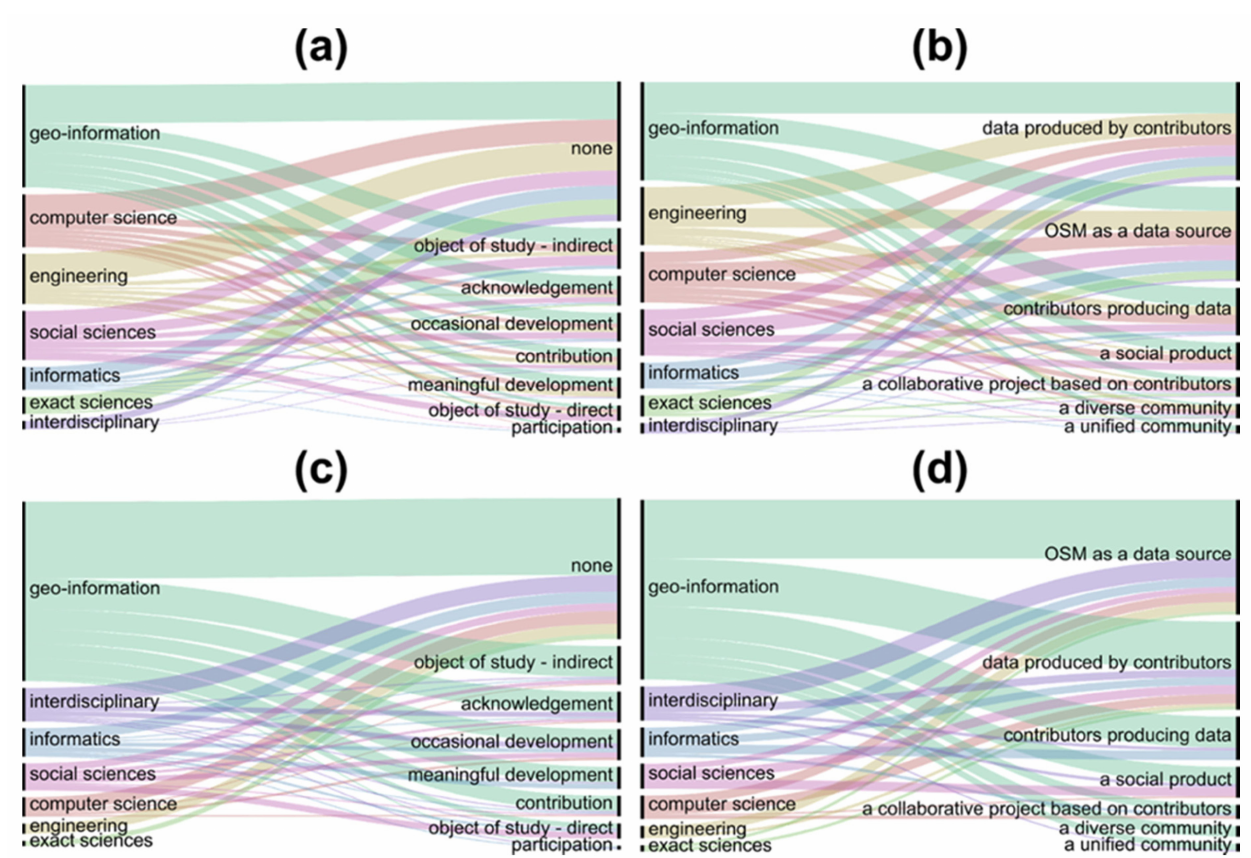
Figure 6. Alluvial diagrams connecting authors’ disciplines with engagement ( a ) and perspective ( b ); journals’ disciplines with engagement ( c ) and perspective ( d